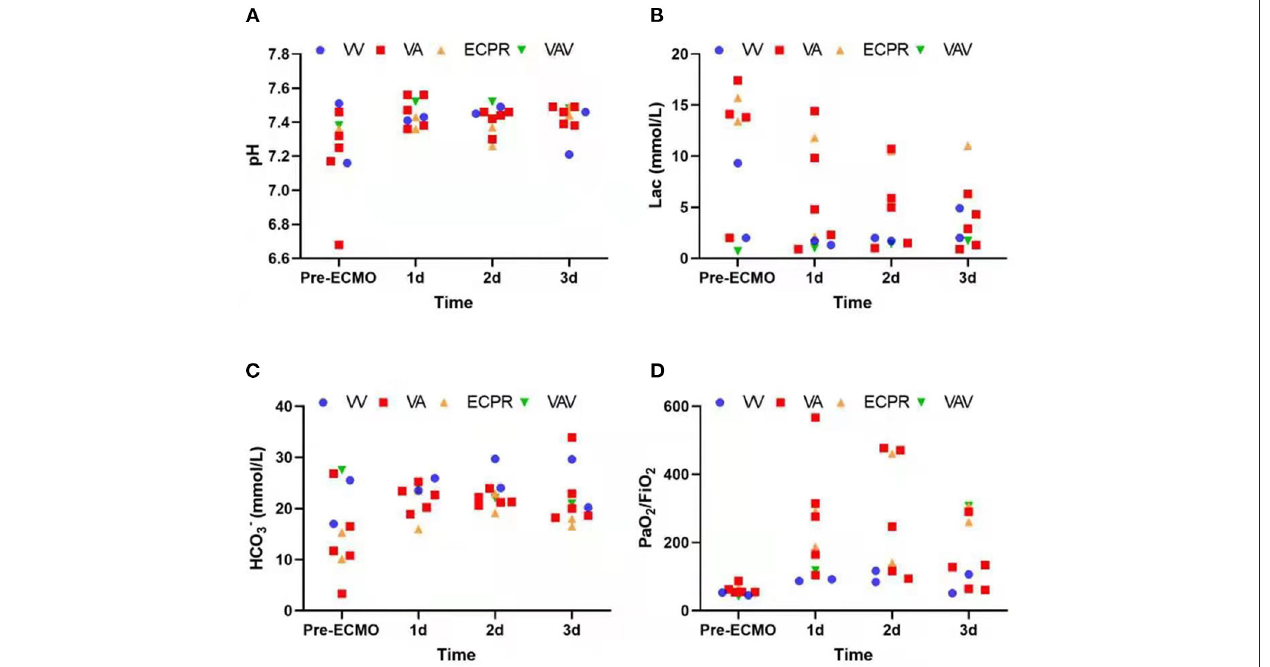
FIGURE 1 | (A–D) Arterial blood gas trends before and during first three ECMO